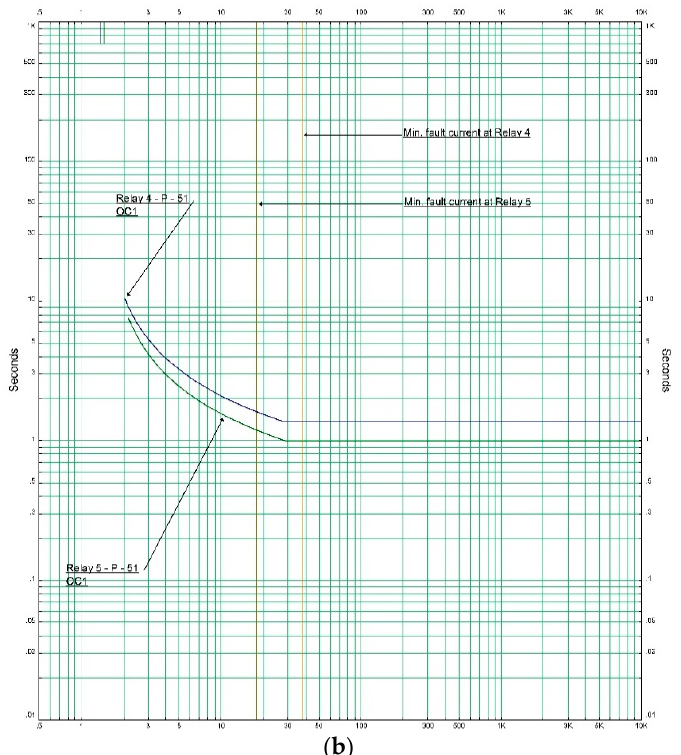
Figure 10. Time-current curves of relays 5 and 4 in case study 1 when applying: ( a ) The proposed algorithm, ( b ) The PSO algorithm.